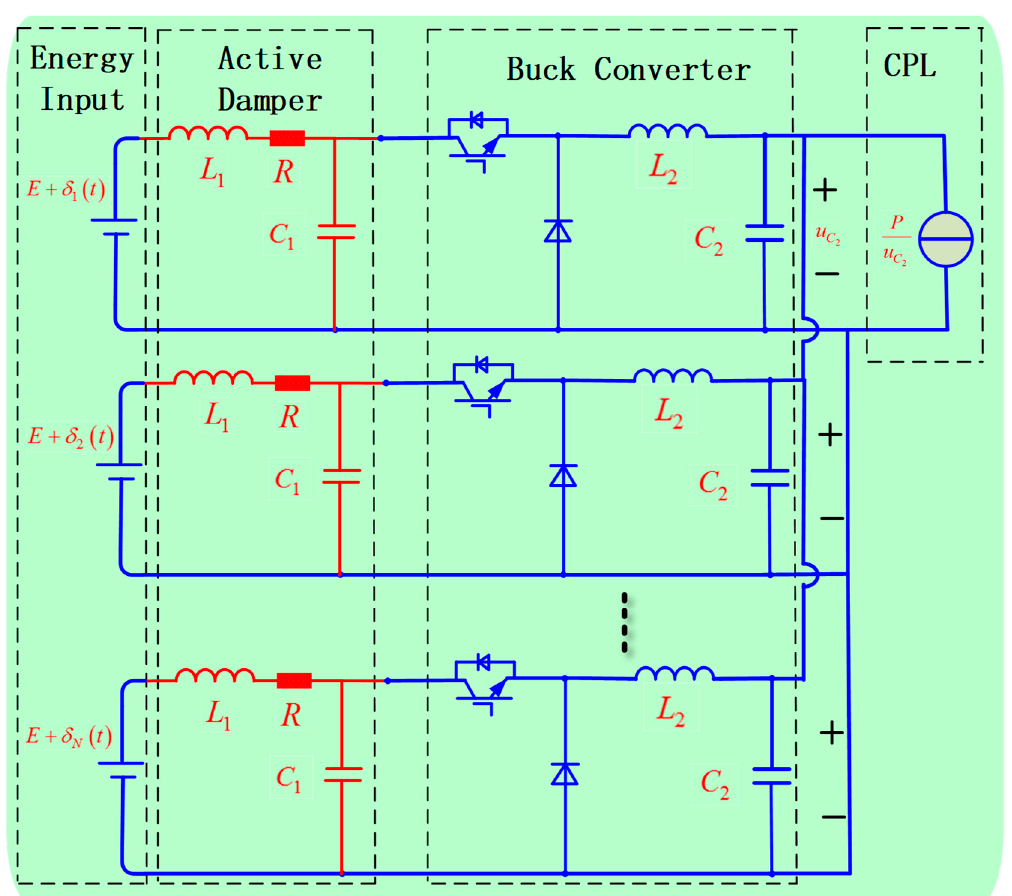
Figure 6. A DC microgrid with N parallel ‐ connected converters.